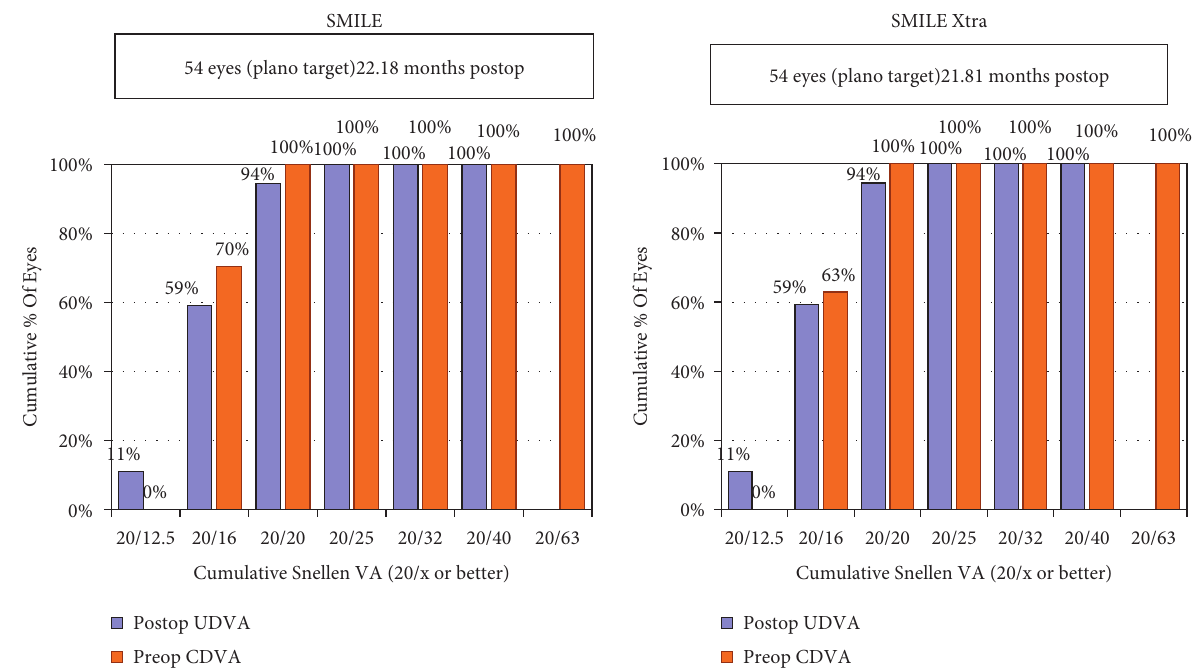
Figure 1: Cumulative histogram for binocular uncorrected distance visual acuity